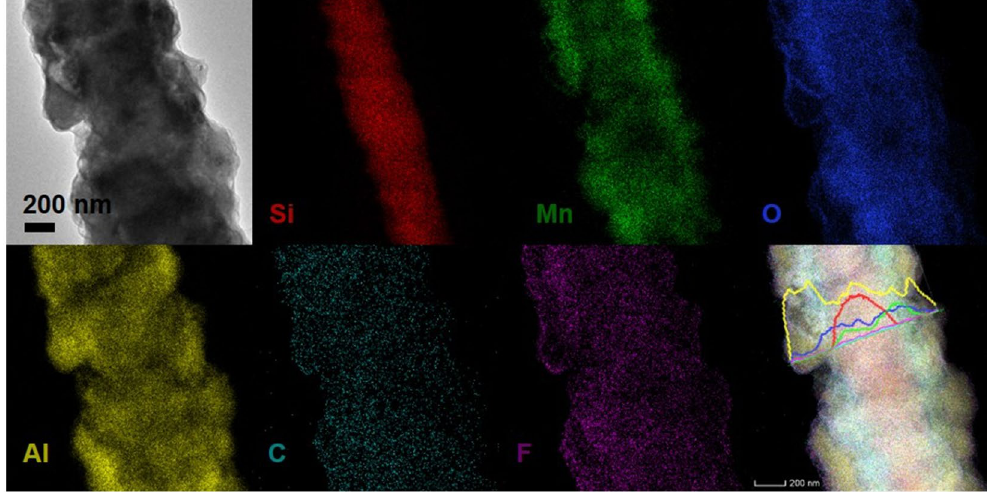
Figure 3. TEM elemental mapping images and line scan spectra of the Si-W/MnO 2 /Al/fluorocarbon rod.